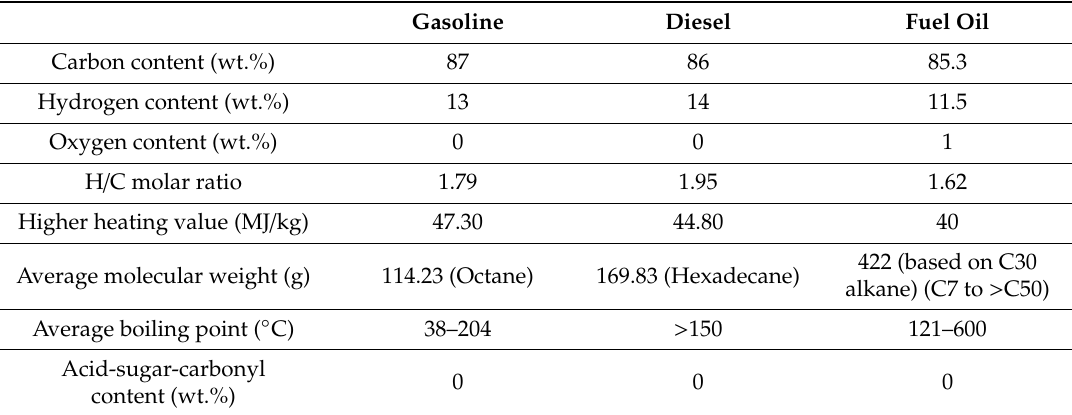
Table 6. Properties of conventional fossil